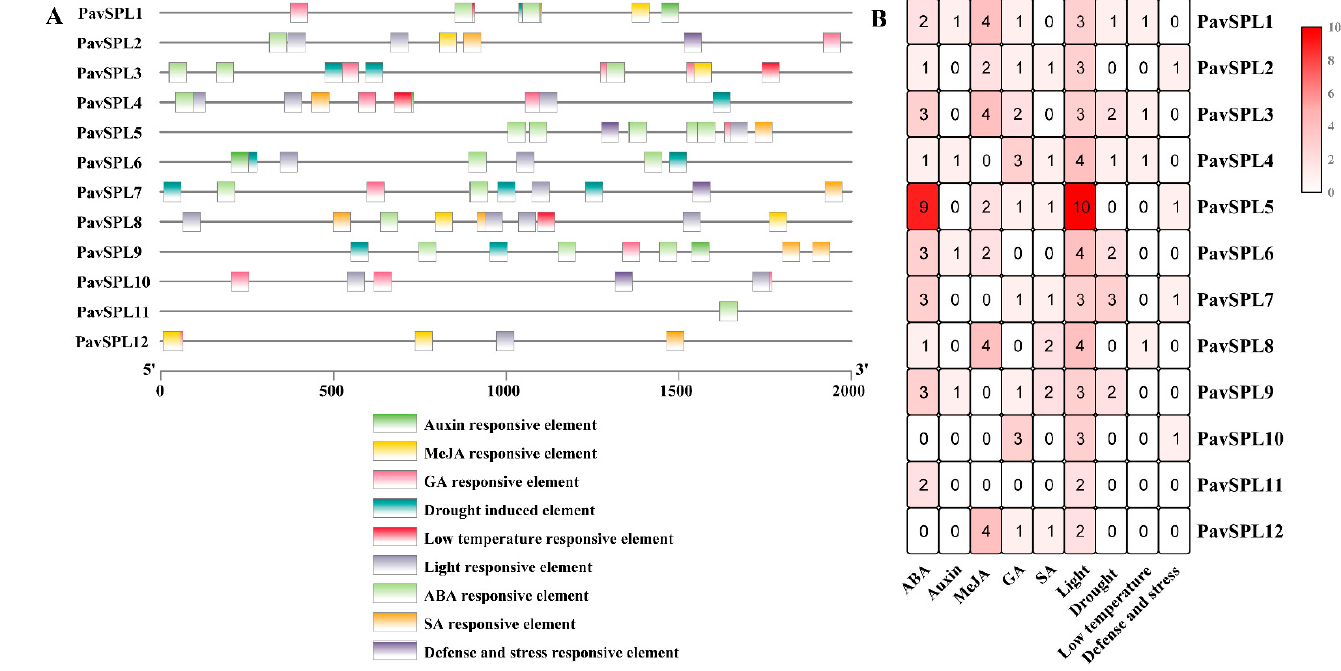
Figure 6. Cis-element of the PavSPL genes in sweet cherry: ( A ) the cis-element analysis of the PavSPL genes, where colorful boxes represent different cis-elements; ( B ) numbers of cis-elements in the PavSPL genes.